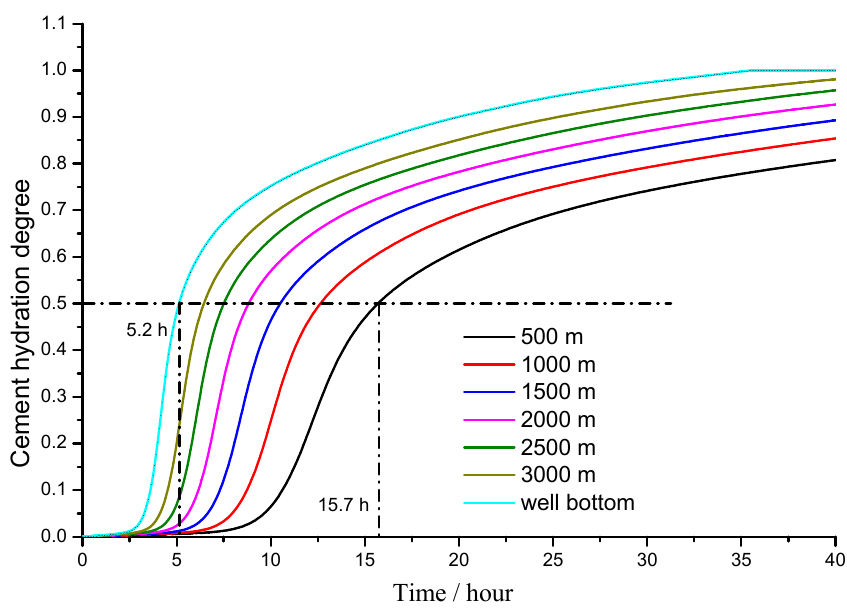
Figure 6. Cement hydration degree development at different depths.